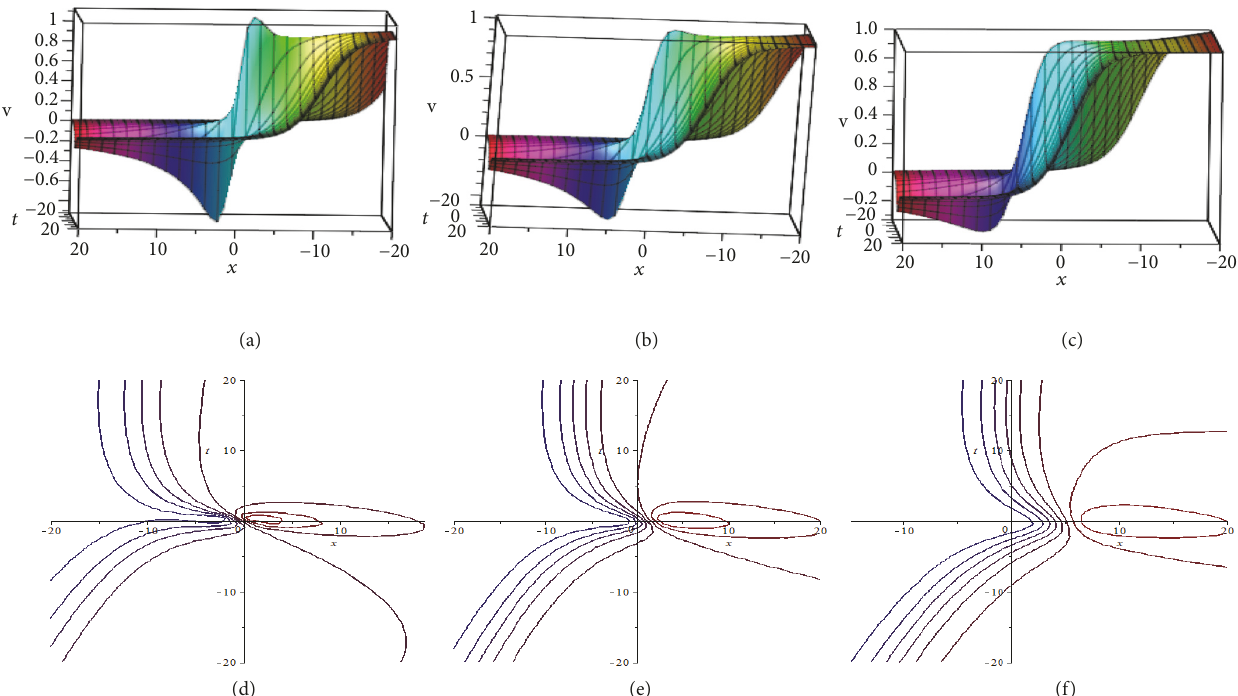
Figure 2: Upper plots: 3D plots for (9) at (a) 𝑦 = 0 , at (b) 𝑦 = 2 , and at (c) 𝑦 = 5 and 𝑧 = 0 . Contour plots (nethermost plots) for (9) at (d) 𝑦 = 0 , at (e) 𝑦 = 2 , and at (f) 𝑦 = 5 and 𝑧 = 0